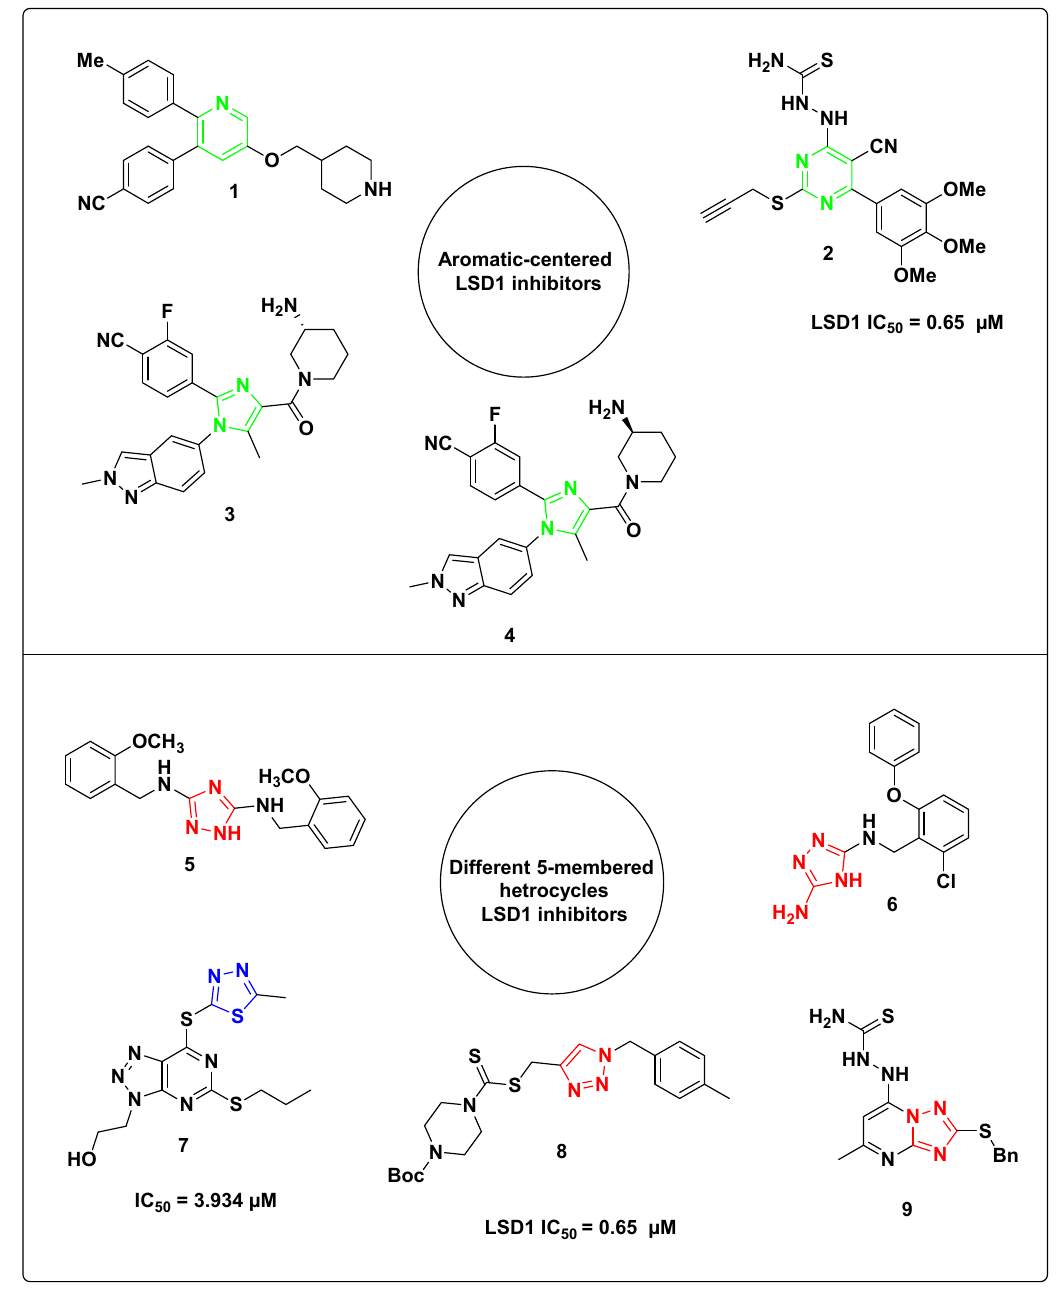
Figure 1. Reported aromatic planar system targeting LSD1 as anticancer agents.